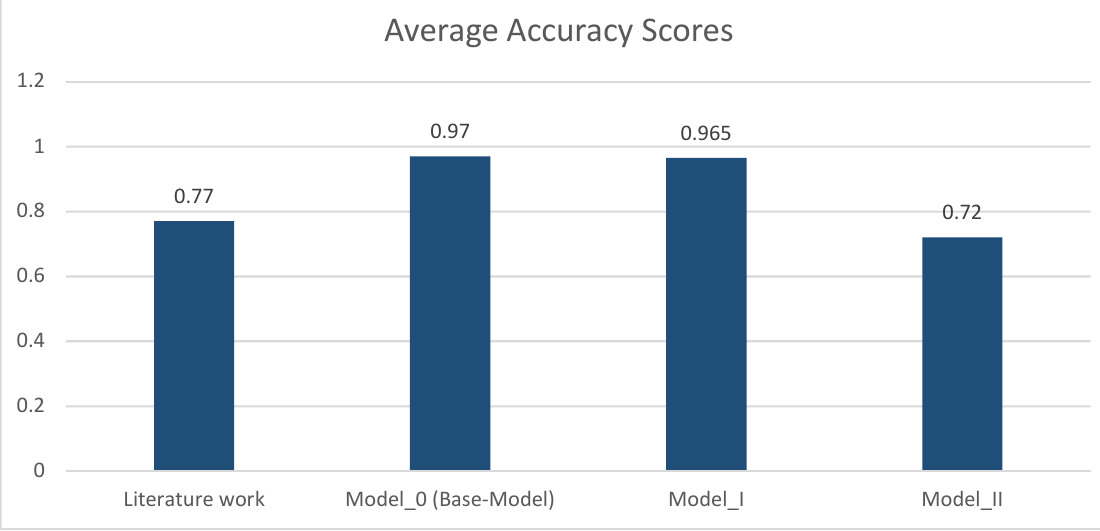
Figure 19. The reported average accuracy scores of experimenting Dataset_II on: (a) literature work; (b) Model_0 (the base model); (c) Model_I; (d) Model_II.